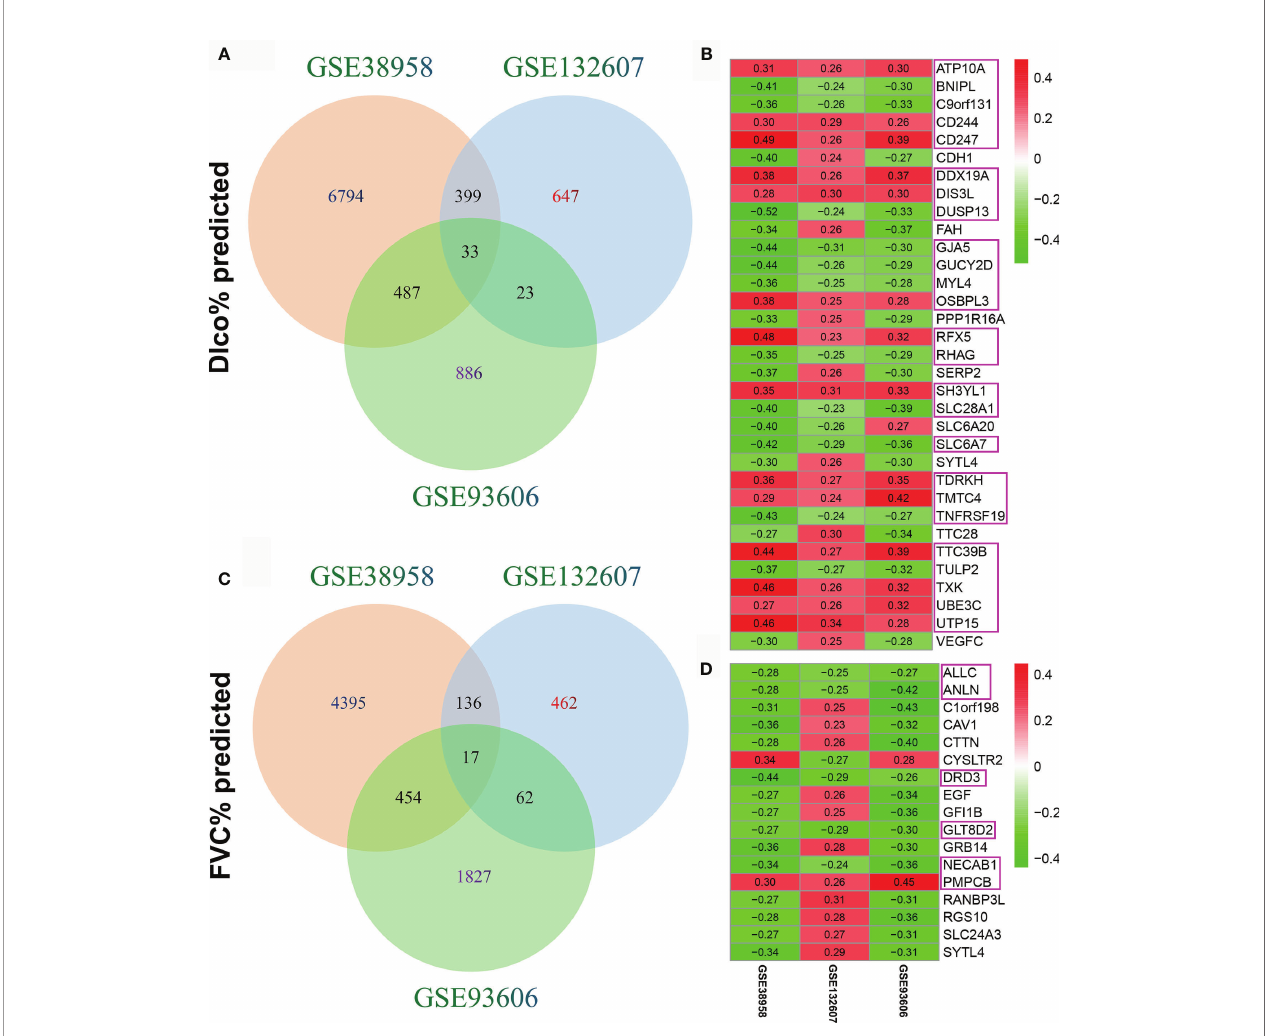
FIGURE 1 | Identi fi cation of candidate hub genes. (A) The intersection of genes associated with Dlco% predicted in the GSE38958, GSE132607, and GSE93606 datasets. (B) Heatmap plot of the 33 genes associated with Dlco% predicted in the three datasets. (C) The intersection of genes associated with FVC% predicted in the three datasets. (D) Heatmap plot of the 17 genes associated with FVC% predicted in the three datasets. The numbers in the heatmap represent the correlation coef fi cients, red represents the positive correlation, green represents the negative correlation, the darker shade of red or green represents the higher correlation level, and the pink rectangles showed the genes were selected as the candidate hub